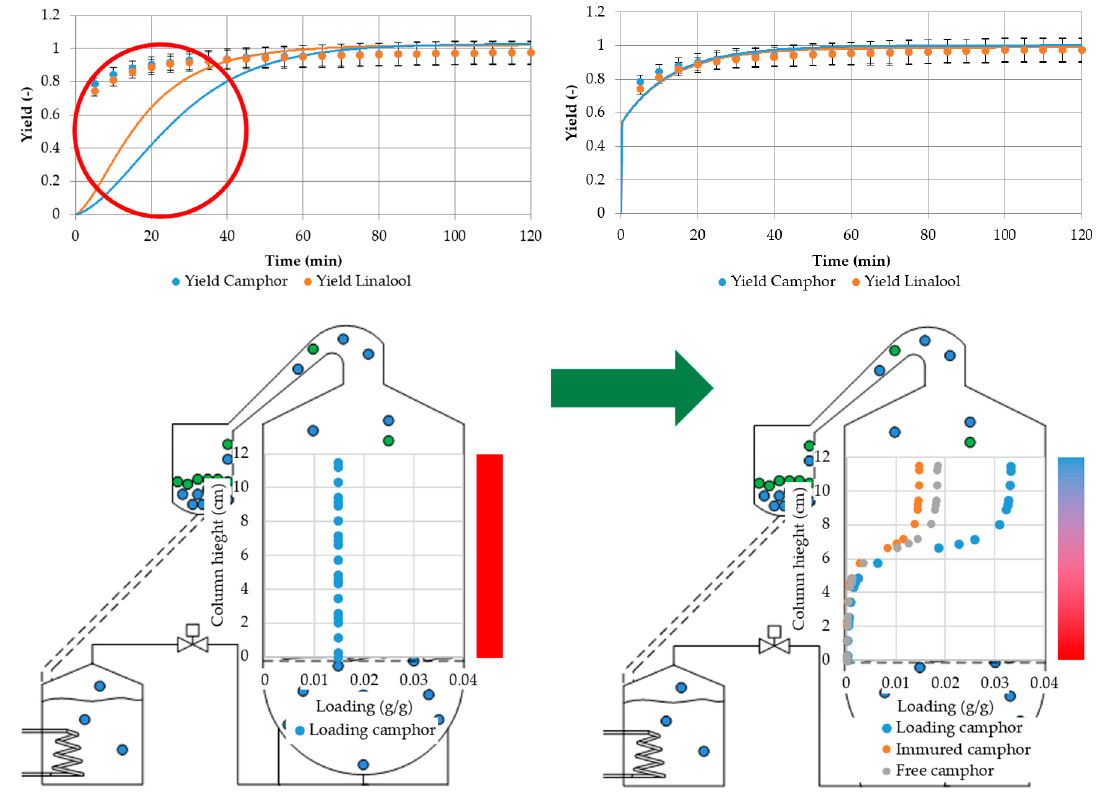
Figure17. Unmodified, evendistributionoftargetcomponentsandmodelresult( leftside ). Introduction Figure 17. Unmodified, even distribution of target components and model result (left side). of heat-up phase in the model ( right side ) for modified initial conditions for lavender. Introduction of heat-up phase in the model (right side) for modified initial conditions for lavender.